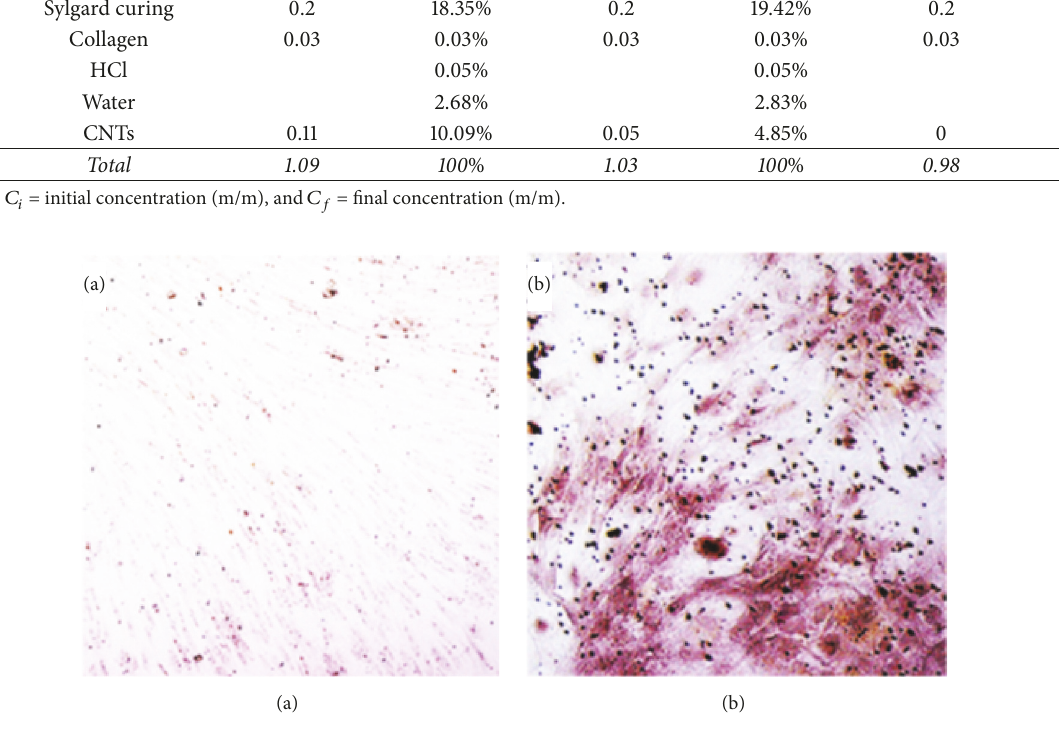
Figure 1: MSCs grown on plasma-treated polystyrene surface (a) left uninduced and (b) induced with osteogenic culture medium and then stained with Alizarin Red S. Induced cultures showed more rounded morphological features and a 21-fold increase in red dye absorption.